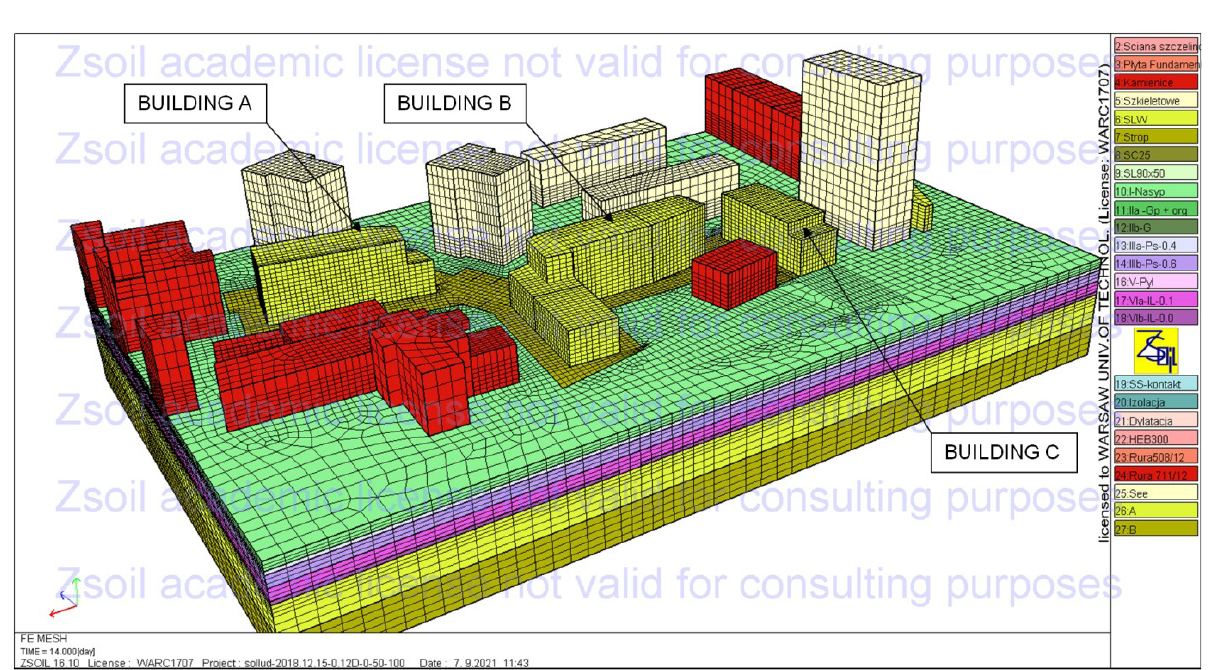
Figure 4: 3D numerical model covering the designed building complex A, B and C, neighbouring buildings and